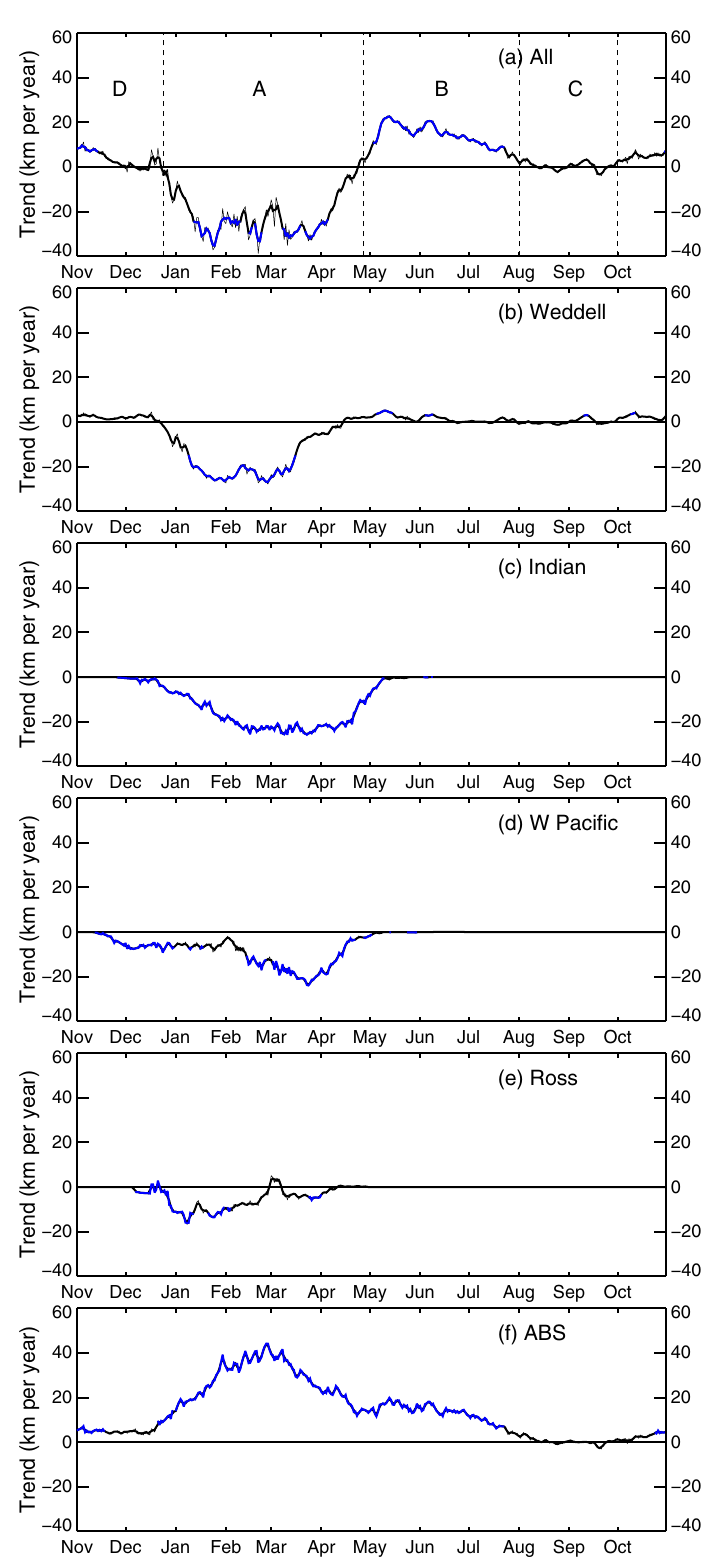
Fig. 5 Plots of the trends (1979 – 2020) in coastal exposure length for each day (km year − 1 ). a Total Antarctic coastline, b Weddell Sea, c Indian Ocean, d W Paci fi c Ocean, e Ross Sea, and f ABS. Statistically signi fi cant values (>95% con fi dence) are highlighted in blue. Thick black and blue lines are based on 3-day smoothing, while thin black lines are unsmoothed daily data. Periods A – D, as marked in ( a ), are mentioned in the